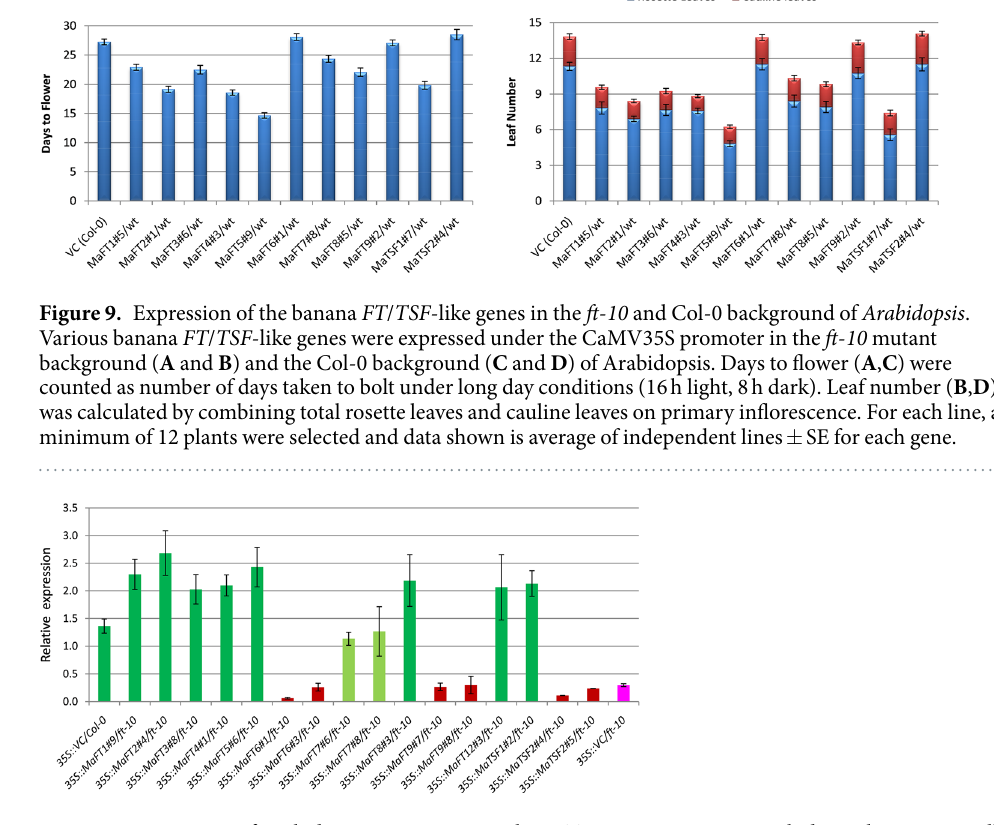
between 18–23 days (6–8 leaves) with MaFT5 expressing plants flowering even earlier in 14–15 days (4–5 leaves). MaFT7 expressers flowered earlier than Col-0 but later than the others in 24 days with 8–9 leaves. MaFT6 , MaFT9 and MaTSF2 had no effect on flowering while MaFT10 and MaFT11 could not be tested. An analysis of the expression of the floral identity gene AP1 which is a target of FT and necessary to initiate flowering was carried out in Arabidopsis lines expressing the different banana FT genes in the ft - 10 background. A clear up-regulation of AP1 was seen in all lines (Fig. 10) except those expressing MaFT6 , MaFT9 and MaTSF2 in spite of the genes being expressed in transgenic plants (Fig. S4). Relatively lower transcript levels were seen in lines expressing MaFT7 that matched the partial restoration phenotype of MaFT7 . Collectively these studies show that at least nine of the 14 FT/TSF like genes namely MaFT1 - MaFT5 , MaFT7 , MaFT8 , MaFT12 and MaTSF1 could functionally interact with the flowering components even in Arabidopsis suggesting a structure that is conserved with AtFT and capable of being recognized by the FT/FD complex of Arabidopsis.